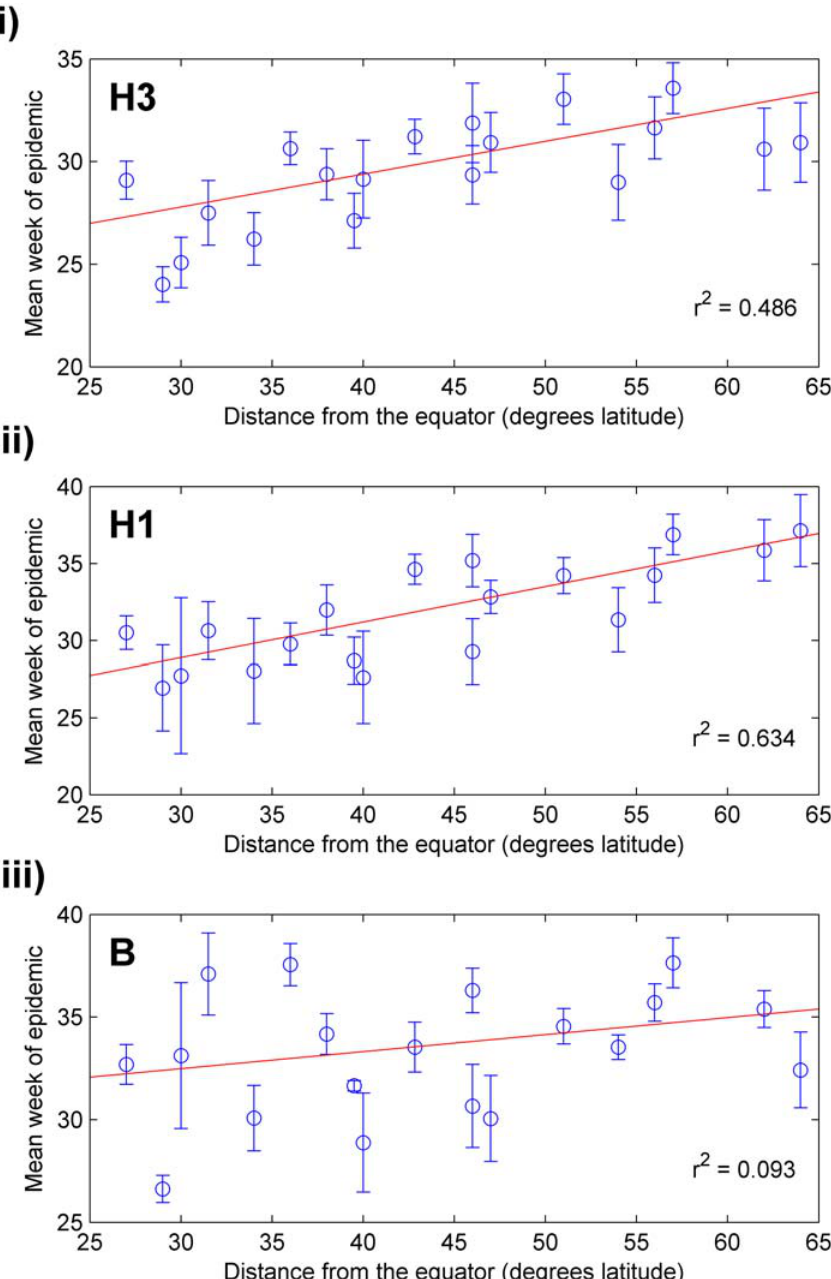
Figure 5. Mean type and subtype epidemic week versus distance from the equator. Mean week of each epidemic was determined for all countries, and the arithmetic mean ( 6 SE) of these values for each country was plotted versus distance from the equator for (i) H3, (ii) H1, and (iii) B. The red lines indicate best fit lines for each type or subtype.